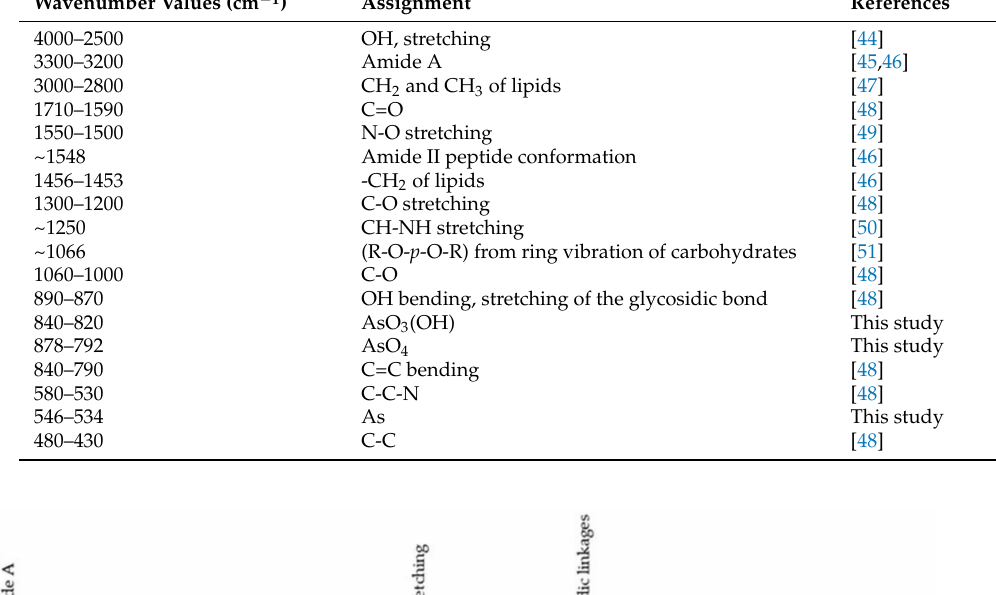
Table 4. ATR-FIR wavenumber values and assignment to functional groups of EPS, As III , and As V .